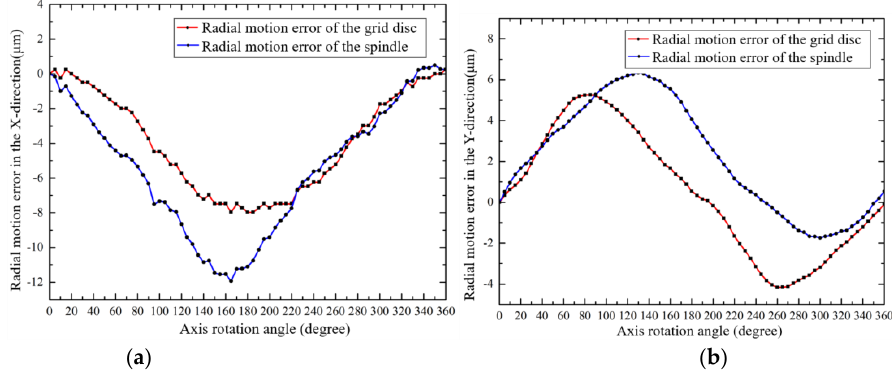
Figure 10. The radial error motions of the grid disc and the shaft: ( a ) X-direction; ( b ) Y-direction